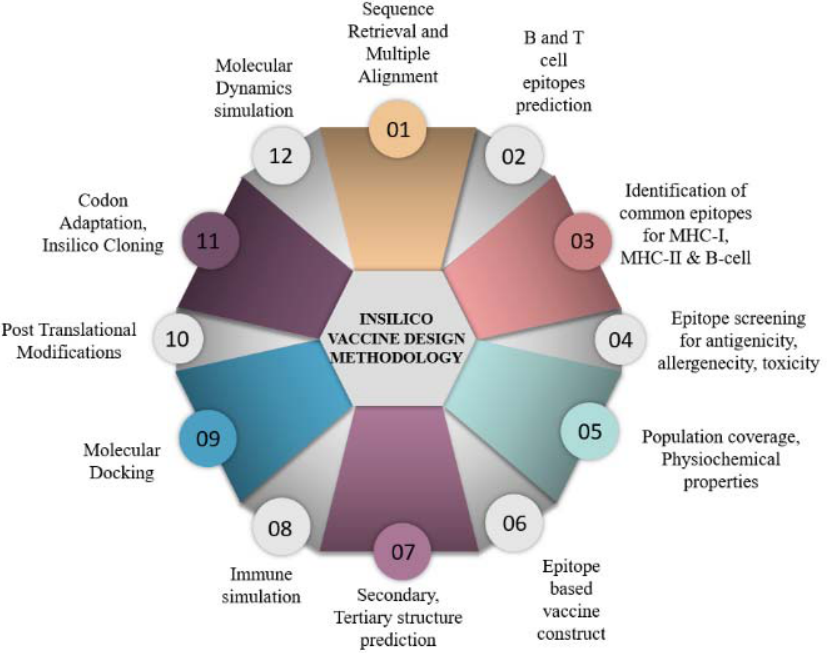
Figure 1. Schematic representation of the strategy followed for the in silico vaccine design against